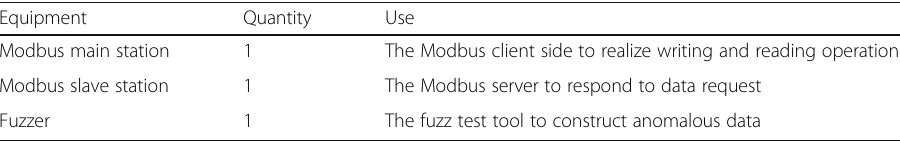
Table 2 Network equipment in the test environment